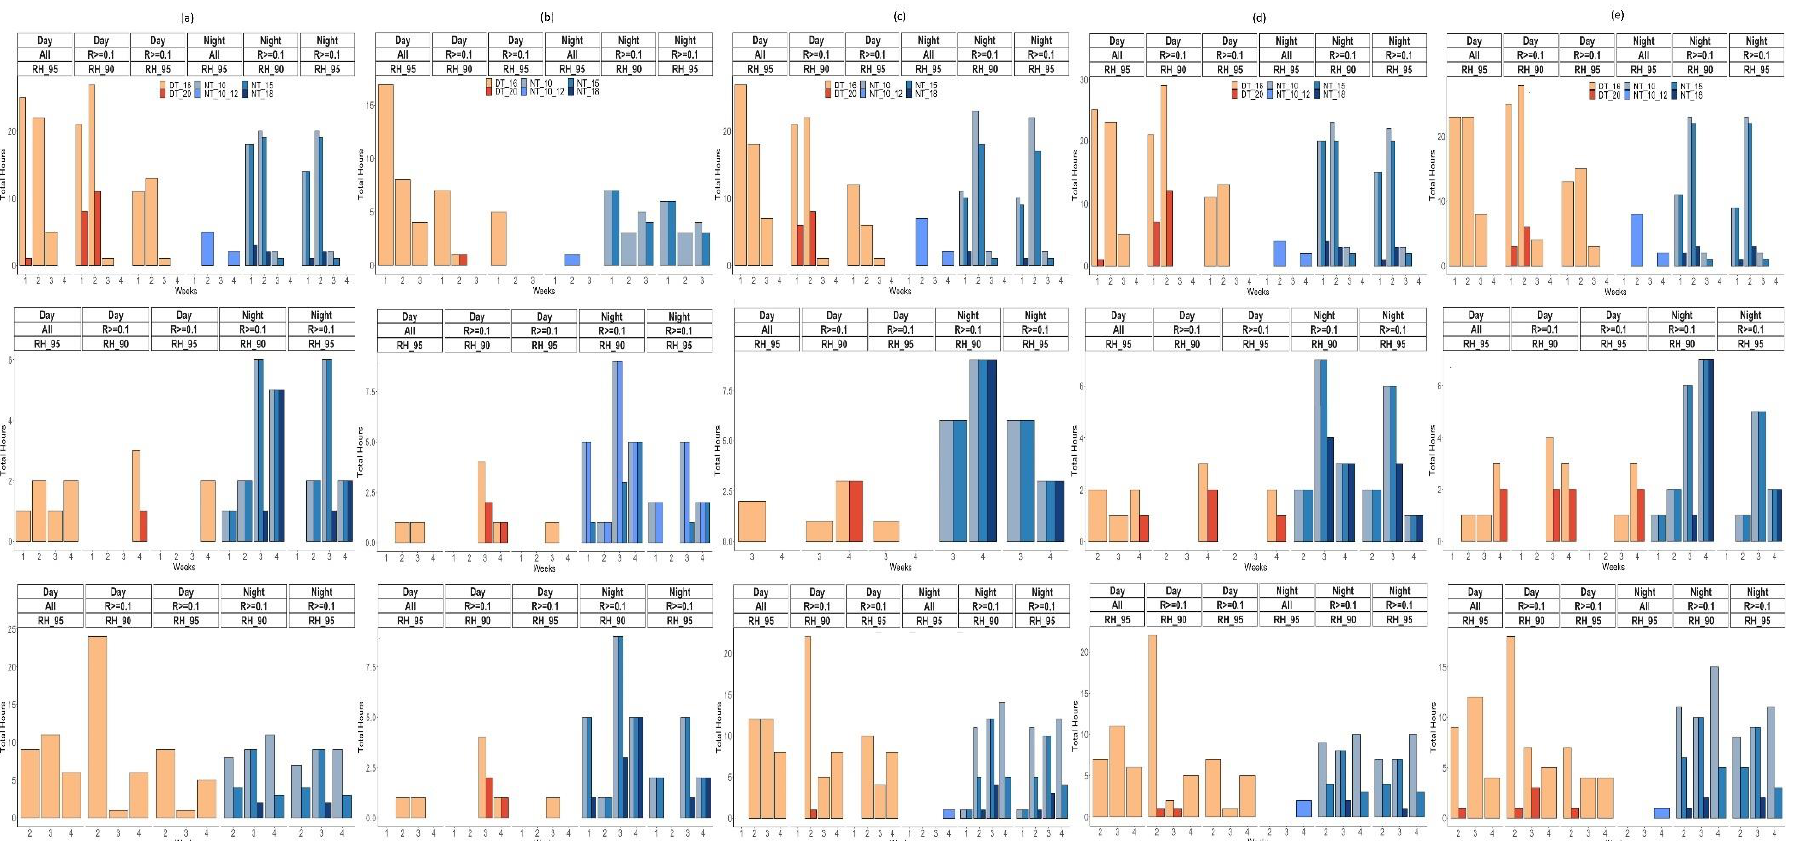
Figure 8. Weekly total hours of weather conditions during the months of June (top) to August (bottom) 2018 at Avernas ( a ), Braffe ( b ), Perwez ( c ), Villiers-le-Peuplier ( d ), and Franc-Waret ( e ). Weather conditions are presented as the defined combinations of rainfall (R), relative humidity (RH), and temperature (T) being met simultaneously. RH_95: RH ≥ 95%; RH_90: RH ≥ 90%; DT_16: daytime T ≥ 16 °C; DT_20: daytime T ≥ 20 °C; NT_10: nighttime T ≥ 10 °C; NT_15: nighttime T ≥ 15 °C; NT_10_12: nighttime T between 10 °C and 12 °C; NT_18: nighttime T ≥ 18 °C. Daytime: 7.00 a.m. to 8.59 p.m.; nighttime: 9.00 p.m. to 6.59 a.m. the following day. (Note differences of scales on the y-axis.).